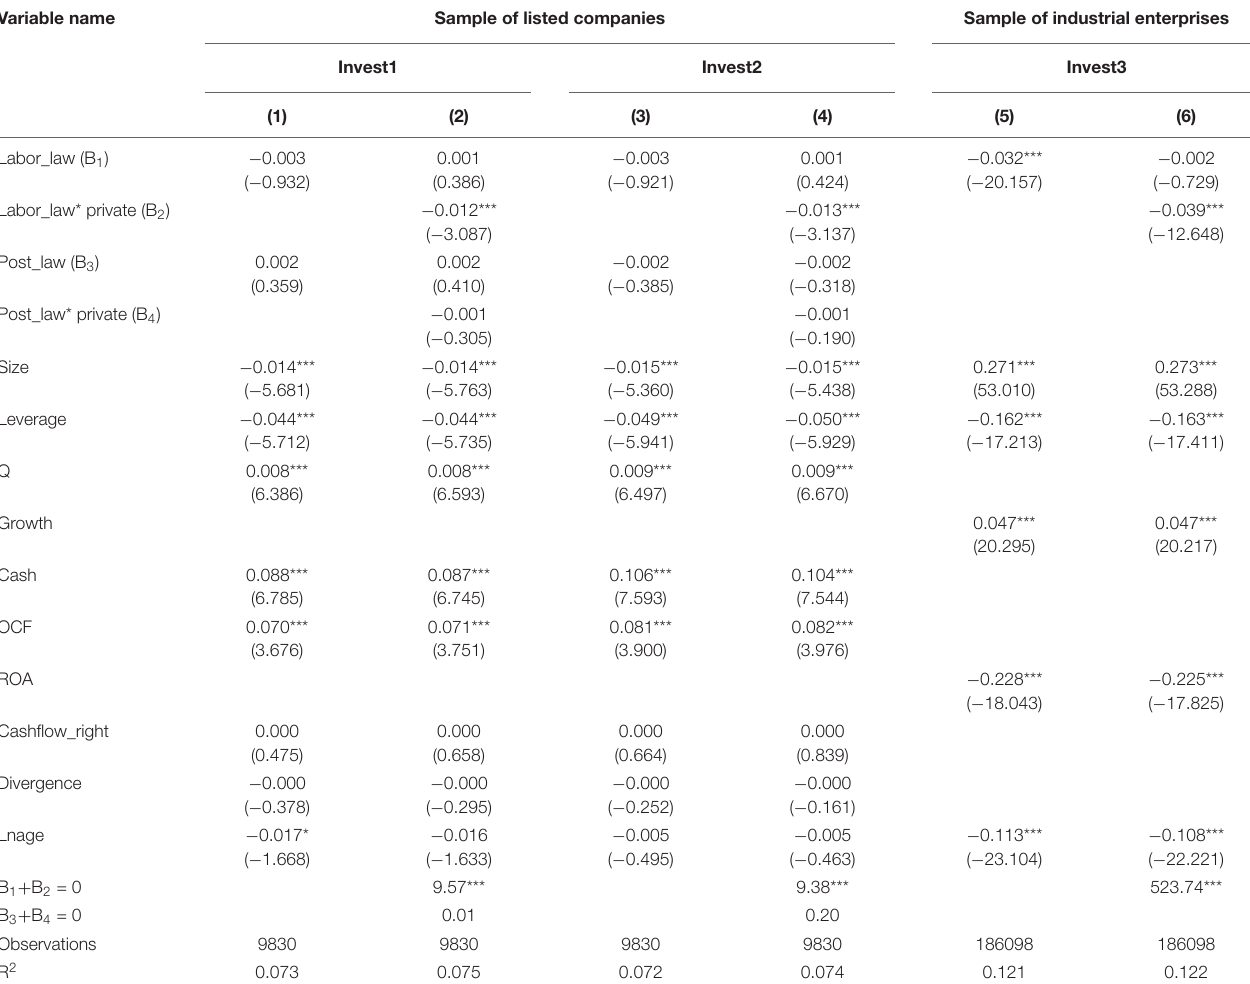
TABLE 2 | Labor Contract Law (LCL), property right nature and enterprise